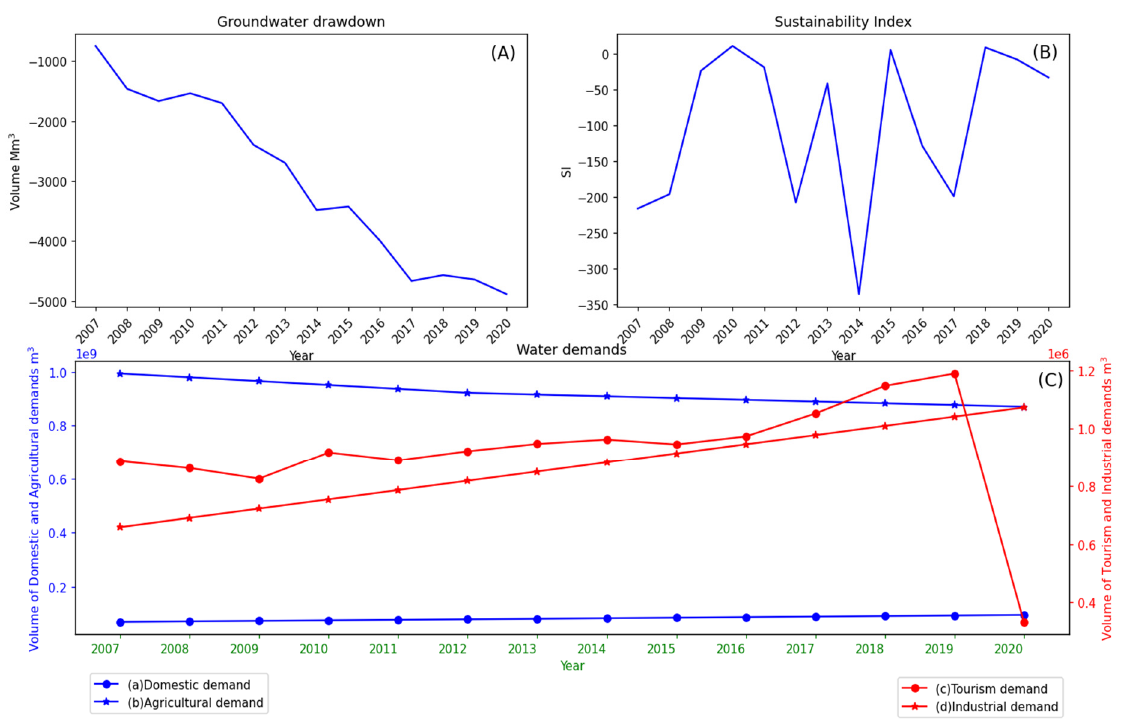
Figure 7. Results of the simulation of the System Dynamics model for the period spanning between 2007 and 2020: ( A ) Groundwater drawdown (Mm 3 ); ( B ) Sustainability index (SI); ( C ) Water demands (m 3 ).